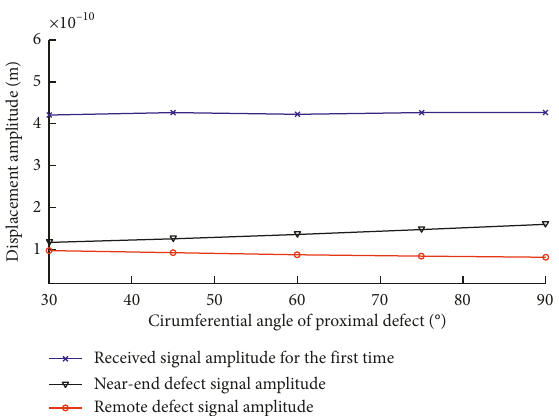
Received signal amplitude for the first time Near-end defect signal amplitude Remote defect signal amplitude Figure 17: Guided amplitude curves of different relative cir- cumferential angles.